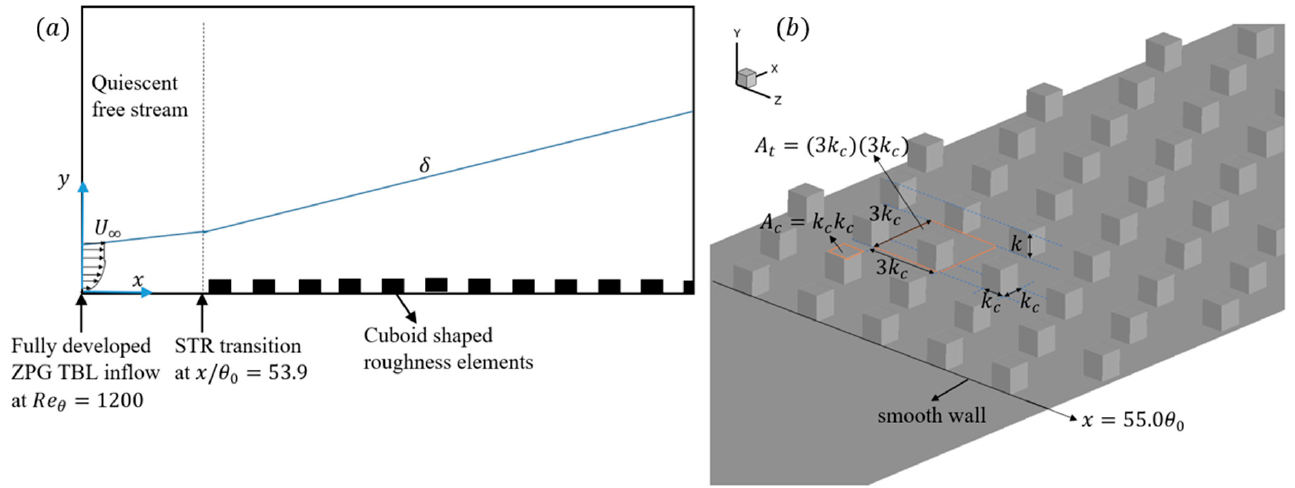
Figure 3. ( a ) Schematic (side view) of flow setup for the STR DNS (not to scale). ( b ) A section of the computational domain that represents the staggered distribution of the roughness elements on the bottom wall.